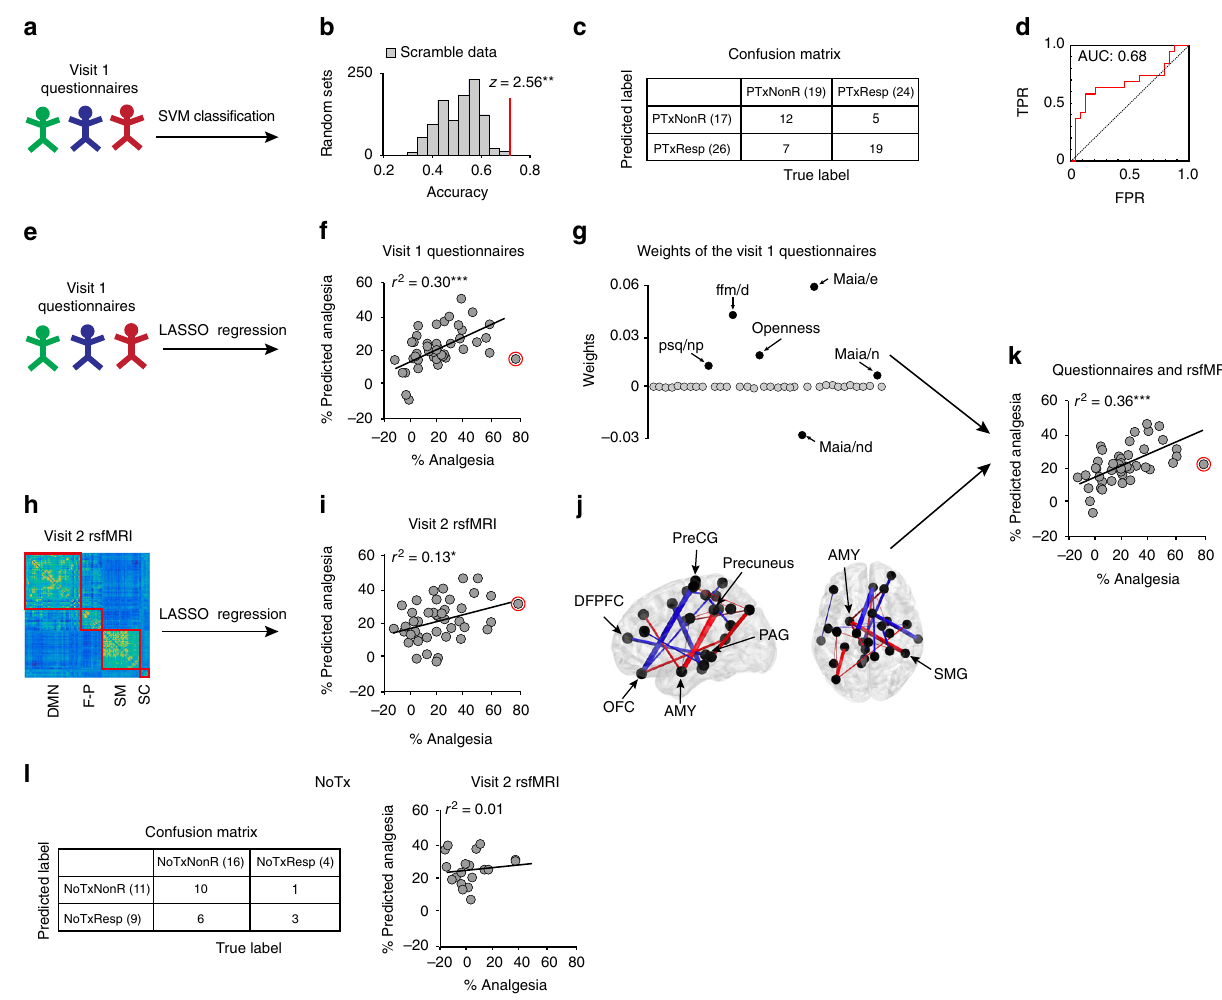
Fig. 5 Machine learning classi fi es placebo response (PTxResp/PTxNonR) and predicts the magnitude of response. a A support vector machine (SVM) classi fi er was applied to the questionnaire data in a nested leave-one-out cross-validation (LOOCV) procedure. b The observed accuracy of this classi fi cation analysis is displayed against the null distribution generated using scrambled codes from 1000 randomized labels. c , d Classi fi cation performance was assessed based on the confusion matrix. The ROC curve shows speci fi city and sensitivity of the model. e , f LASSO regression was applied to the questionnaire data and predicted the magnitude of response in the left-out patients. g Averaged weights across the n = 43 loops of the cross- validation procedure show that six psychological factors predicted the magnitude of response . h , i Features selected from rsfMRI within each training sample predicted the magnitude of response in the left-out patients. j A single set of consensus weights was generated by averaging the weight of each feature across the n = 43 loops; this consensus set is projected back onto the brain for display. Nodes of the most frequently selected features (>0.84 of loops) are labeled on the fi gure k . Linear regression analysis indicated that the predicted magnitude of response from rsfMRI at V2 and from personality at V1 were independent contributors that jointly explained 36% of the variance in actual response to placebo treatment. l The classi fi er ( a ) and the regression model ( k ) failed to predict placebo response in patients of the NoTx group. The red circle marks the predicted magnitude of response